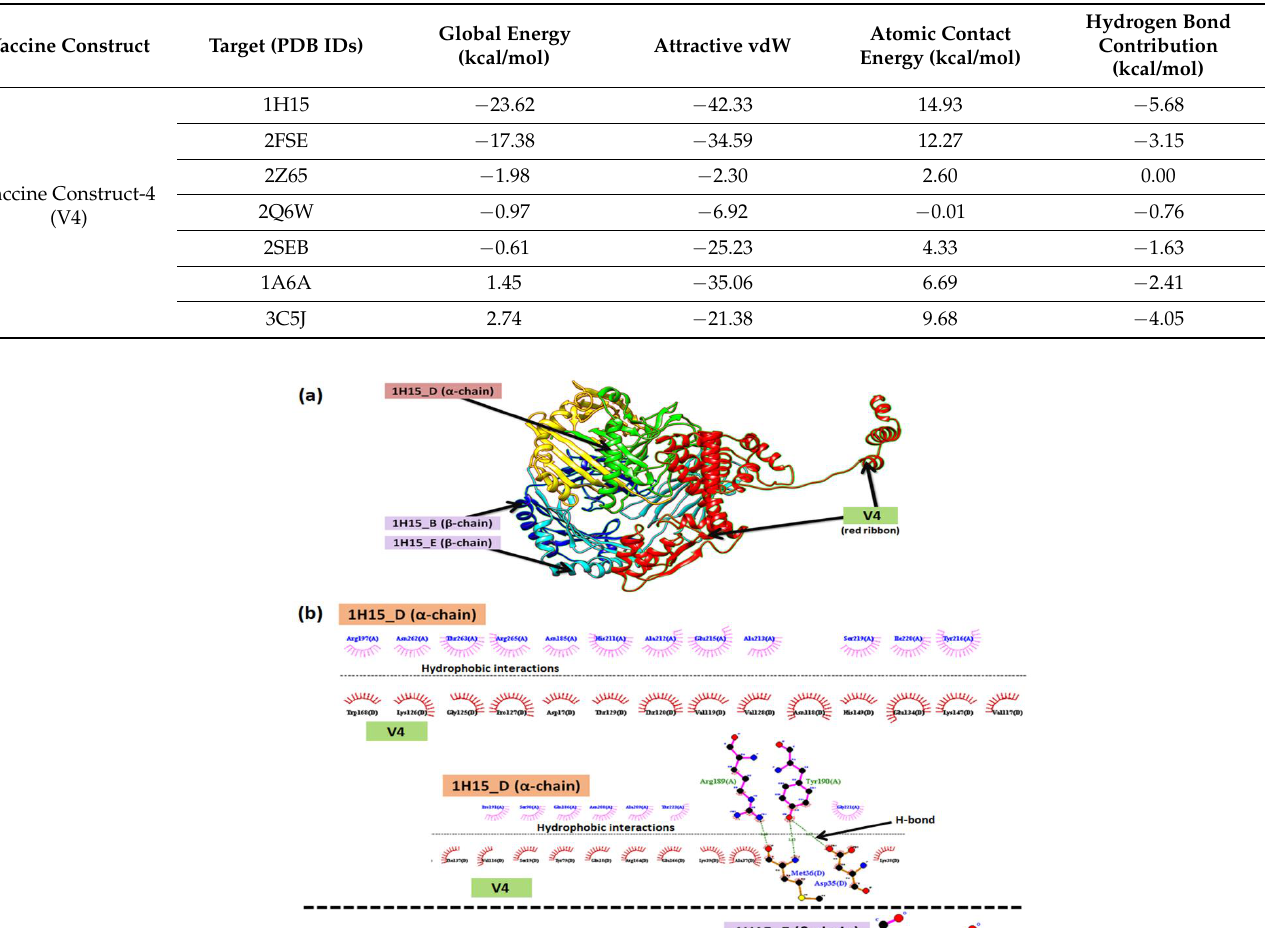
Table 8. The relative binding parameter values of the docked complexes.